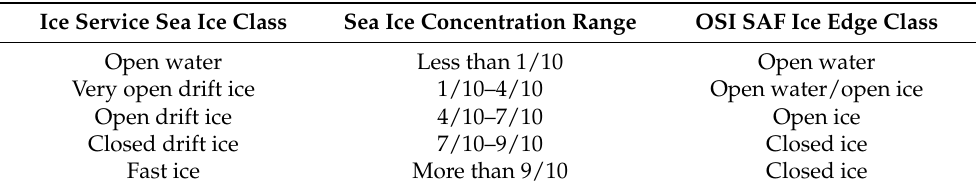
Table 4. The correspondence between ice service sea ice class, sea ice concentration range, and OSI SAF ice edge